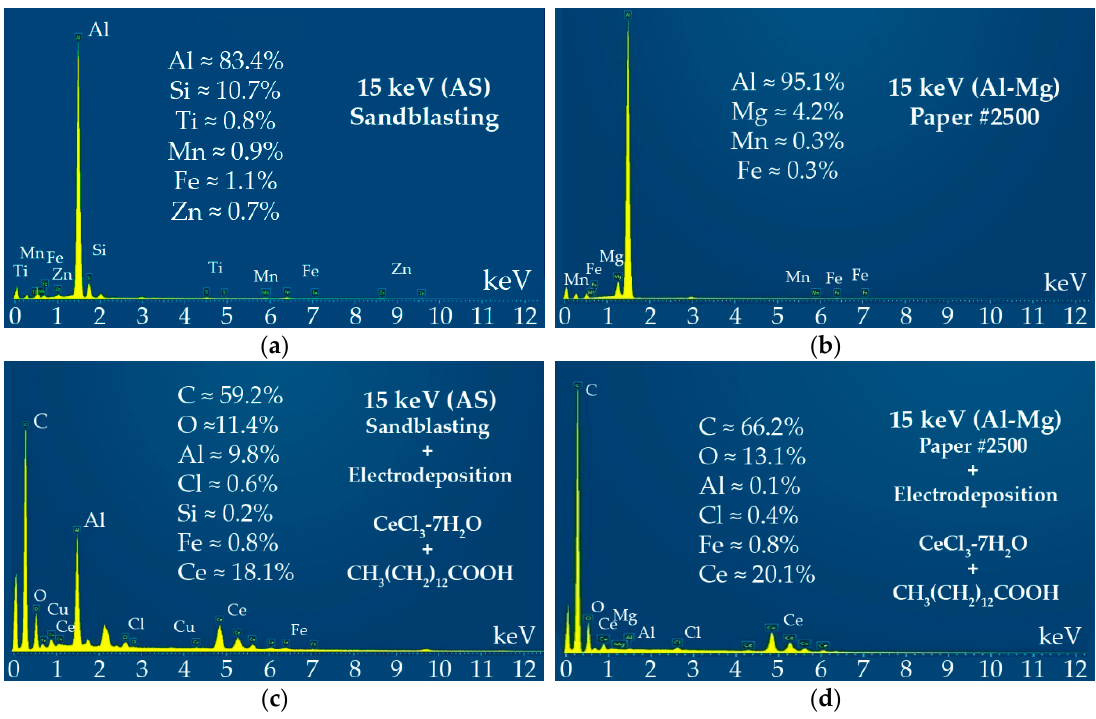
Figure 6. Energy-dispersive X-ray spectroscopy (EDX) spectra of ( a ) sandblasted AS substrate, ( b ) sanded Al-Mg substrate, ( c ) treated AS substrate after electrodeposition (cerium chloride and myristic acid) at 30 V for 10 min, and ( d ) treated Al-Mg substrate after electrodeposition at 40 V for 30 min.